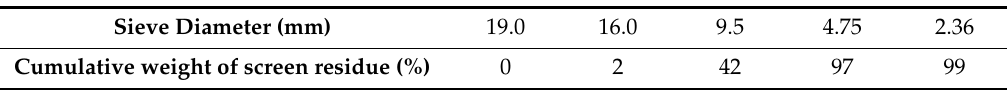
Table 3. Gravel grading.